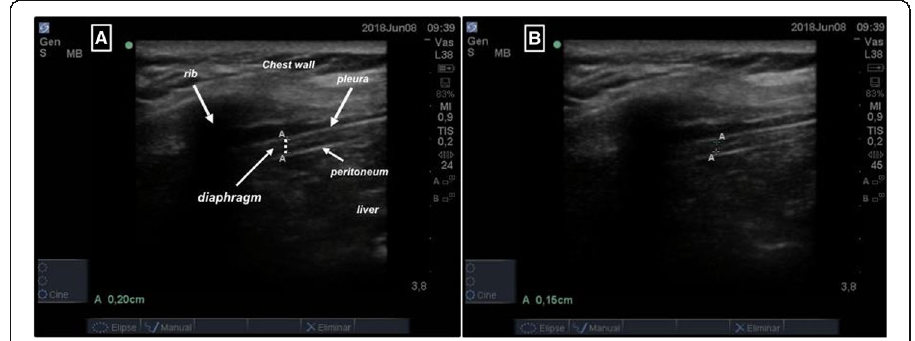
Fig. 2 Representative ultrasound image at the zone of apposition in B-mode view of the diaphragm during inspiration ( a ) and expiration ( b ). The diaphragm is identified as a 3-layer comprising two hyperechoic lines representing the pleural and peritoneal membranes and a middle hypoechoic layer representing the diaphragmatic muscle itself ( with permission of the Intensive Care Unit from the Hospital Universitario de